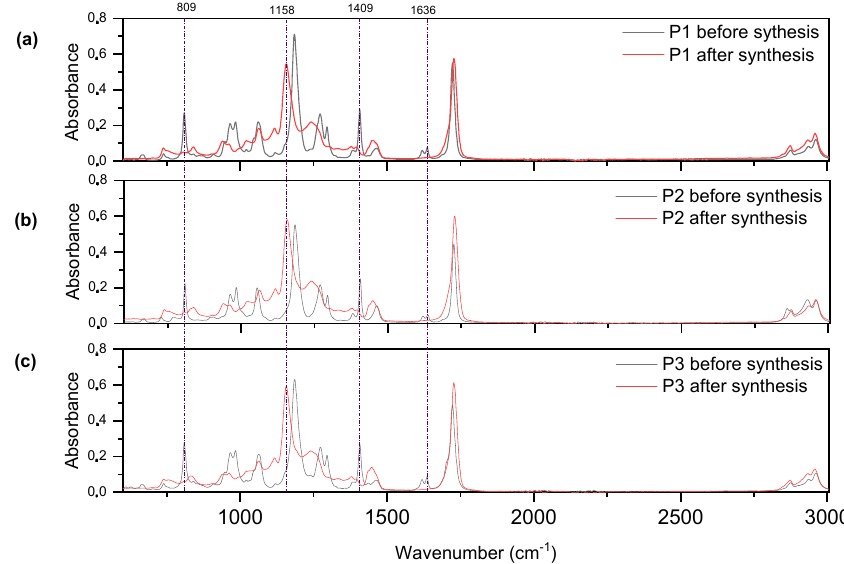
Figure 4. FTIR spectra of the reaction mixture before the copolymerization and the obtained product after the reaction for ( a ) P1, ( b ) P2, and ( c ) P3.